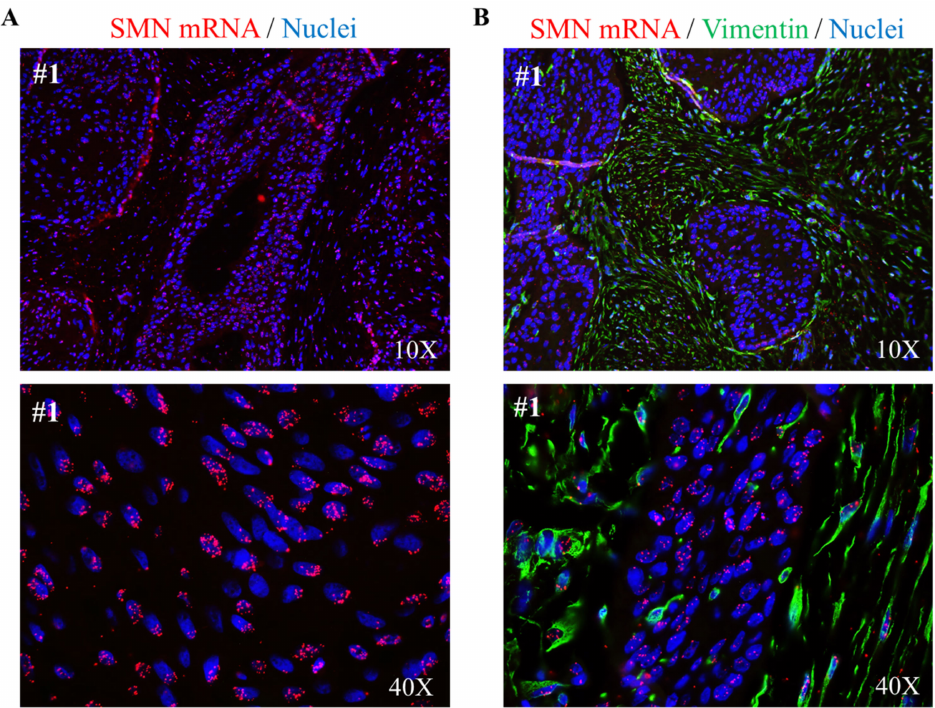
Figure 3. SMN mRNA localization in laryngeal squamous cell carcinoma. ( A ) Representative images of fluorescence microscopy. SMN mRNA (red dots) was detected by a padlock assay in LSCC tissue from patient #1. Nuclei were stained with DAPI (blue). Images were acquired with a 10 × or 40 × objective. ( B ) Representative images of fluorescence microscopy. LSCC sections were subjected to a combination of vimentin immunostaining (green) and a padlock assay targeting SMN mRNA (red). Nuclei were stained with DAPI (blue). Images were acquired with a 10 × or 40 × objective, as indicated.